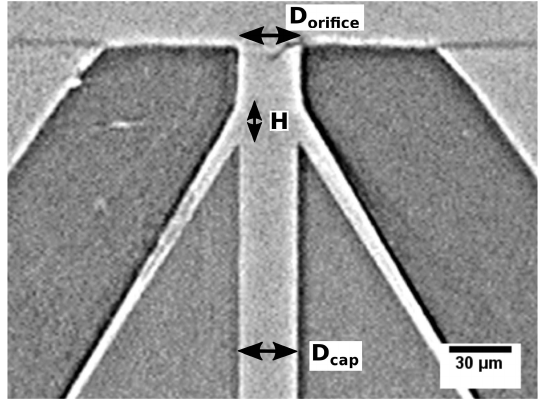
Figure 1 A slice through an X-ray tomogram of the nozzle used in the FLASH experiments. The nozzle is almost cylindrical/symmetric and consists of a sharpened glass capillary with an inner bore diameter of 30 m m surrounded by an injection-molded ceramic conical piece. The capillary transports the sample liquid to the nozzle exit where a free-standing liquid jet is formed by gas flowing through the interstitial space and out through the orifice. Tomography was performed with 25 keV photon energy at the P05 endstation at the PETRA III synchrotron